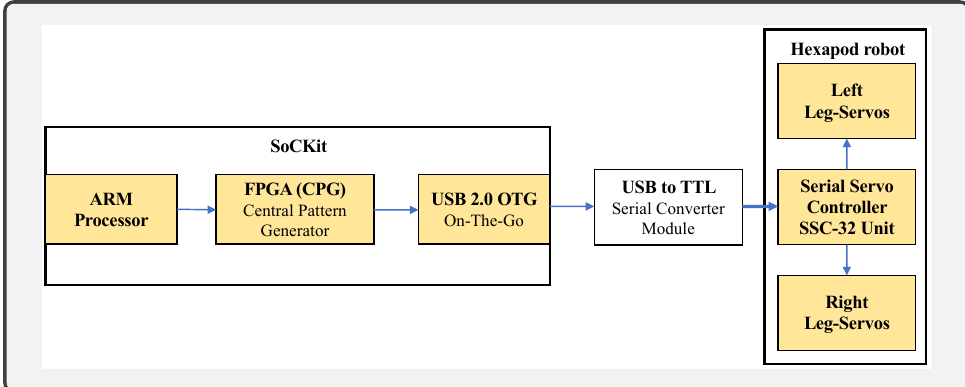
Figure 4. SoCKit-hexapod robot interconnection using a USB-TTL adapter and an SSC-32 V2.0 board.